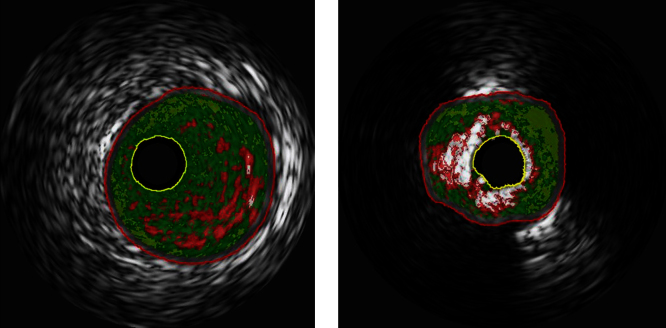
Representative VH-IVUS images of lesions with low (0.29; left panel) and high EPA/AA (0.82) ratios (right panel). Both images indicate dark green (fibrous), light green (fibro-fatty), red (necrotic core), and white (dense calcium). The low EPA/AA lesion (left panel) was predominantly fibrous (dark green, 66.89%) and contained few regions of dense calcium (white, 0.37%). In contrast, the high EPA/AA lesion (right panel) contained a high proportion of dense calcium regions (white, 22.76%).